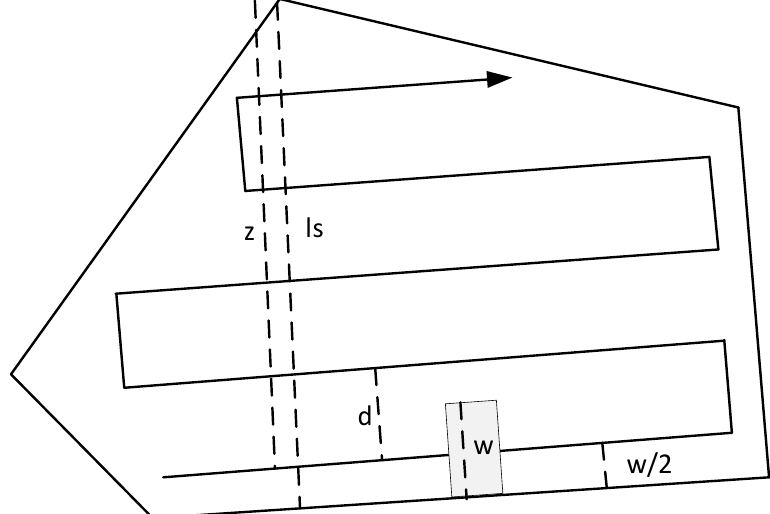
Figure 6. Image of the values needed to calculate the number of turns.